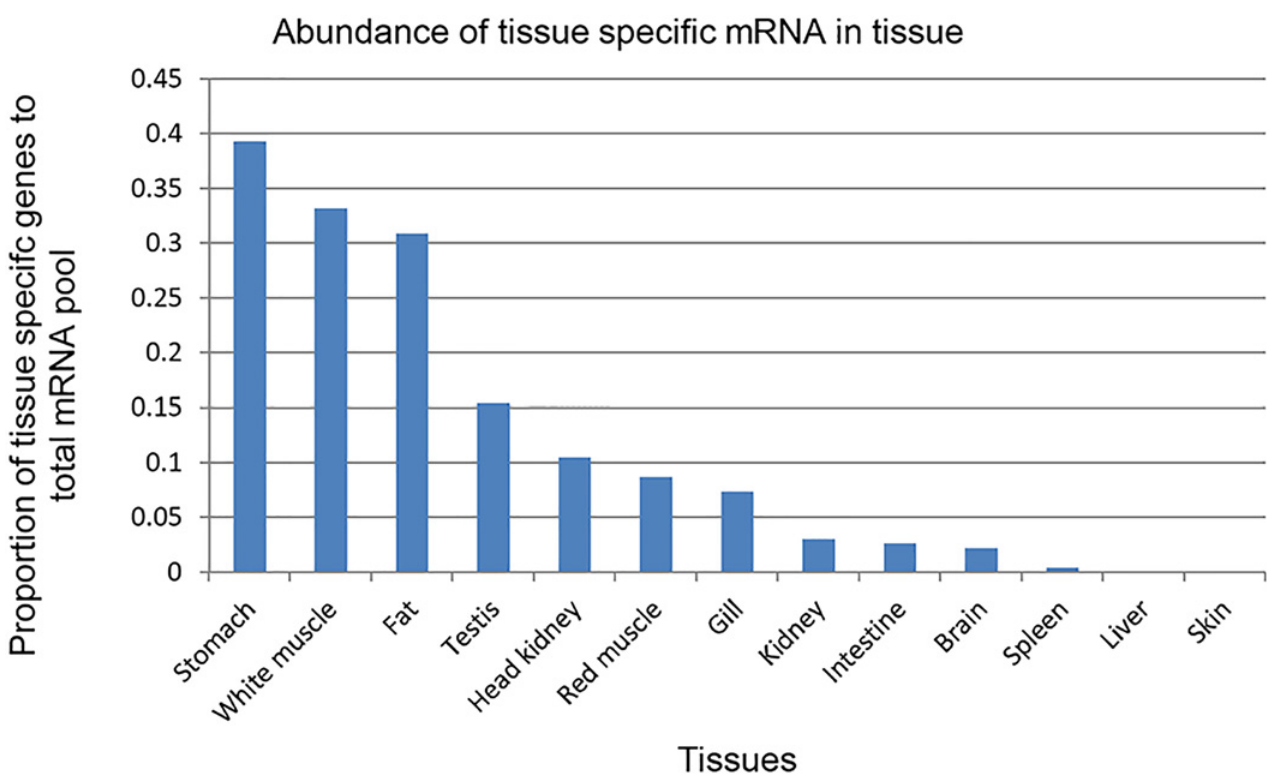
Fig 8. Transcript abundance of tissue-specific genes in various tissues. White muscle, stomach, and fat showed high abundances of tissue specific transcripts, while, skin and liver exhibited low abundance of tissue-specific